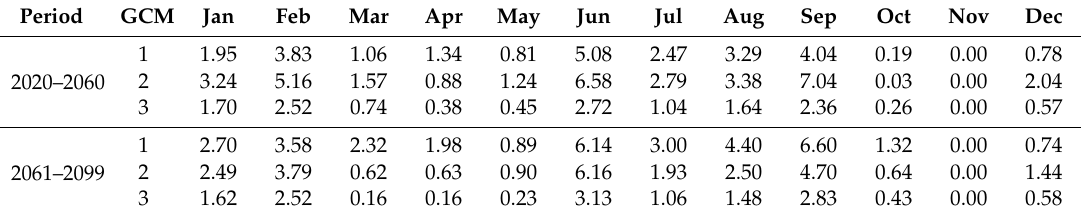
Table 11. RCP 2.6 Future Water Stress Index (WSI) estimations.